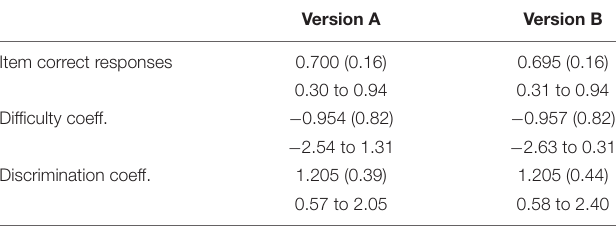
TABLE 2 | Mean correct response scores (with standard deviations and range in brackets) per item, difficulty and discrimination coefficients as a function of versions of